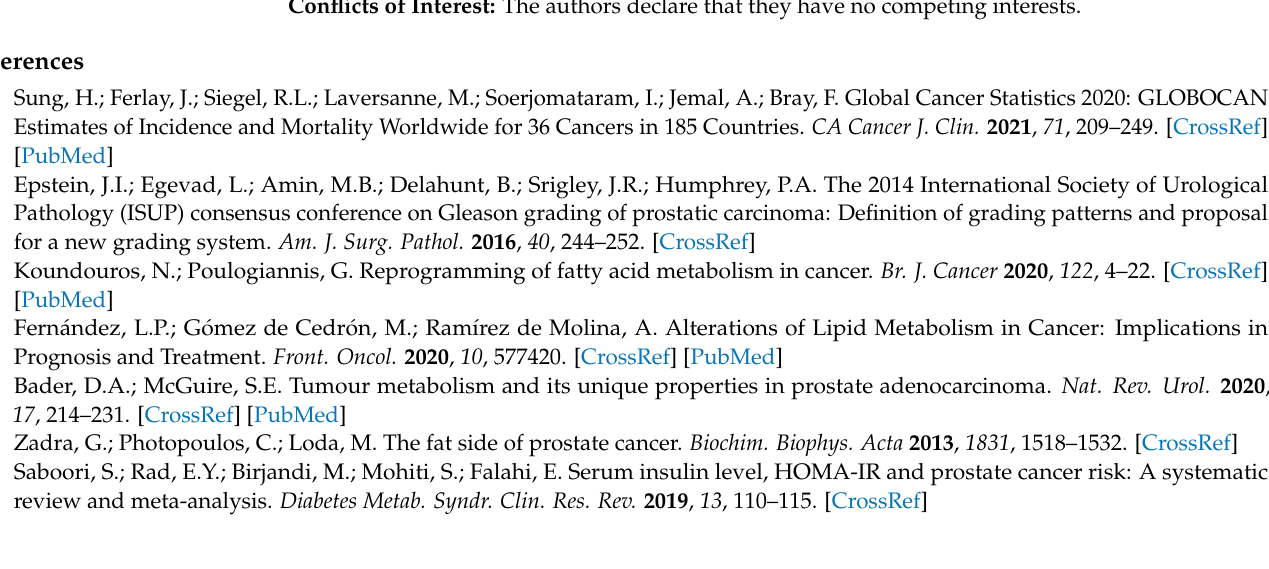
Figure S3: Complete Western blotting results, referring to Figure 3. Figure S4: Effect of sTWEAK stimulation on several signaling pathways in the PCa cell models. Figure S5: PC-3 cells were treated with inhibitors of noncanonical and canonical NK-kB signaling. Figure S6: Complete Western blotting results, referring to Figure